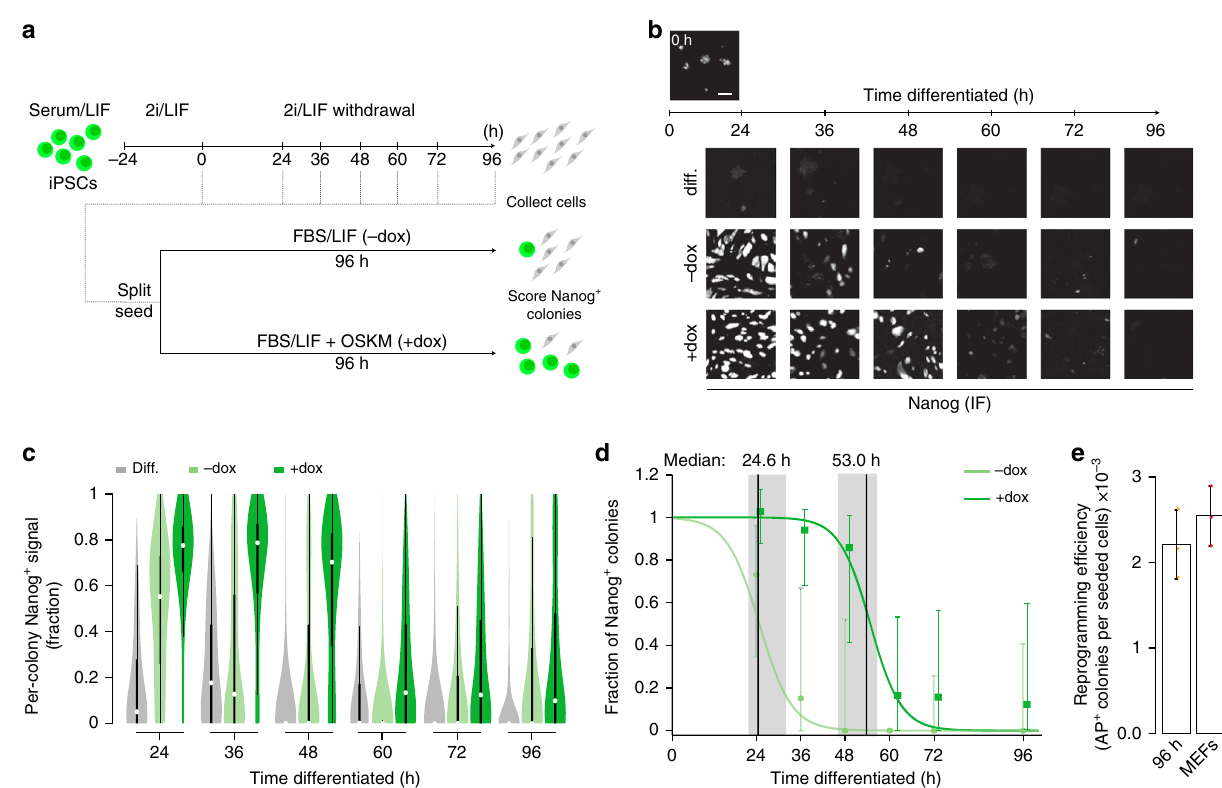
Fig. 1 A somatic-like barrier to reprogramming is established early during differentiation. a Schematic of experimental system to measure reversion back to a NANOG + state by extrinsic or intrinsic conditions. At set intervals following 2i/LIF withdrawal, single cells are re-seeded into serum/LIF, either in the absence ( – dox) or presence ( + dox) of doxycycline (2 µ g/ml) to induce ectopic OSKM expression. The number of NANOG + colonies was counted after 96 h. b Representative IF images showing the loss of NANOG signal over differentiation ( “ diff. ” , top row) and the distinct NANOG + colony-forming ef fi ciency under – dox and + dox conditions (imaged 96 h after the respective differentiation times; scale bar = 200 µ m). All experiments were performed with n = 3 biological replicates, comprised of four technical replicates. c Distribution of NANOG signal (by immunostaining) within RFP-segmented colonies for differentiating cells ( “ diff. ” , gray), cells re-seeded into serum/LIF ( “– dox ” , light green), or the serum/LIF with OSKM induction ( “ + dox ” , dark green). Distributions are over the fraction of colony area that is NANOG positive. White dot indicates the median; boxes represent interquartile range showing central 50% of data and whiskers indicate 25 th and 75 th percentile data. n > 500 for 96 h and n > 9,000 for 24 – 72 h conditions. All experiments were performed with n = 3 biological replicates, comprised of four technical replicates. d Ef fi ciency of iPSC colony-forming ability (fraction of NANOG positive pixels over the colonies) generated from IF images (panel b) and normalized to iPSC controls. NANOG + colonies are computationally segmented, counted and normalized to the number of NANOG + colonies generated from undifferentiated (0 h) iPSCs placed into serum/LIF. Data points represent the median values from panel c normalized to the control. Error bars represent the 25 th − 75 th percentile. Grey highlighted regions indicate the 25 th − 75 th percentile range for the estimated transition times (medians, vertical black lines) for the two conditions. Error bars for + dox are shifted to the right. Note that values are normalized ratios with respect to 0h, hence error bars may extend beyond 1. All experiments were performed with n = 3 biological replicates, comprised of four technical replicates. e Quanti fi cation of Alkaline Phosphatase positive colonies after 12 days of dox induction from iPSCs differentiated for 96 h or secondary MEFs generated from the same iPSC line. Reprogramming ef fi ciency is calculated as the number of colonies per cells plated. Error bars indicate standard deviation of n = 3 reprogramming experiments in technical